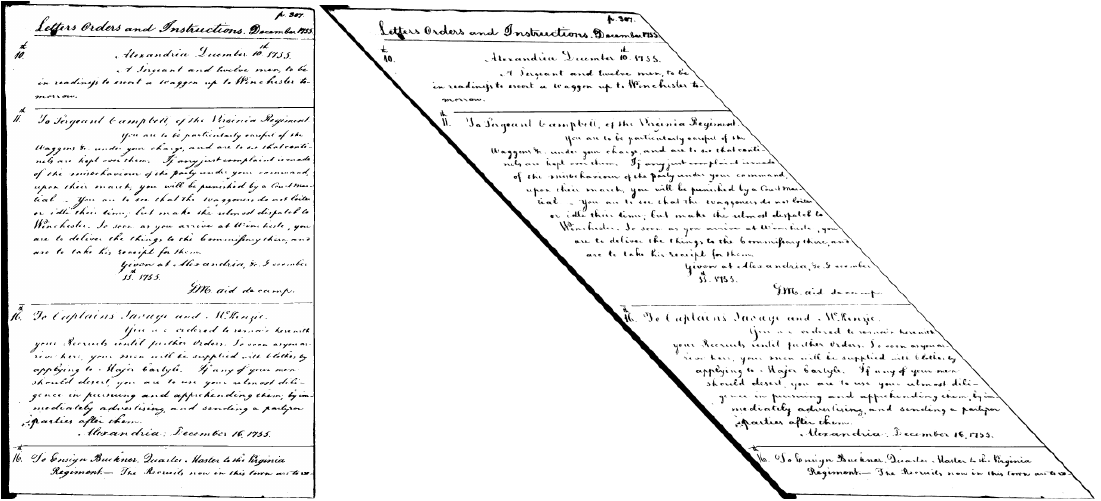
Figure 7. Application of our slant removal technique on a sample from the George Washington DB ( left ); corrected by −42.5° ( right ).